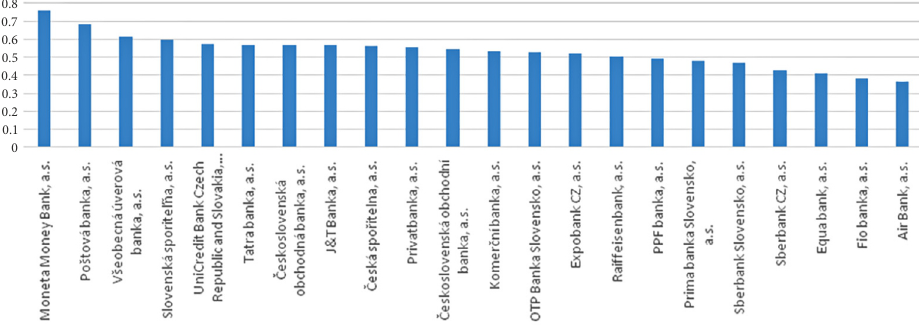
Fig. 3. Ranking of the analyzed Czech and Slovak banks according to the obtained SAW values Source : prepared by authors.